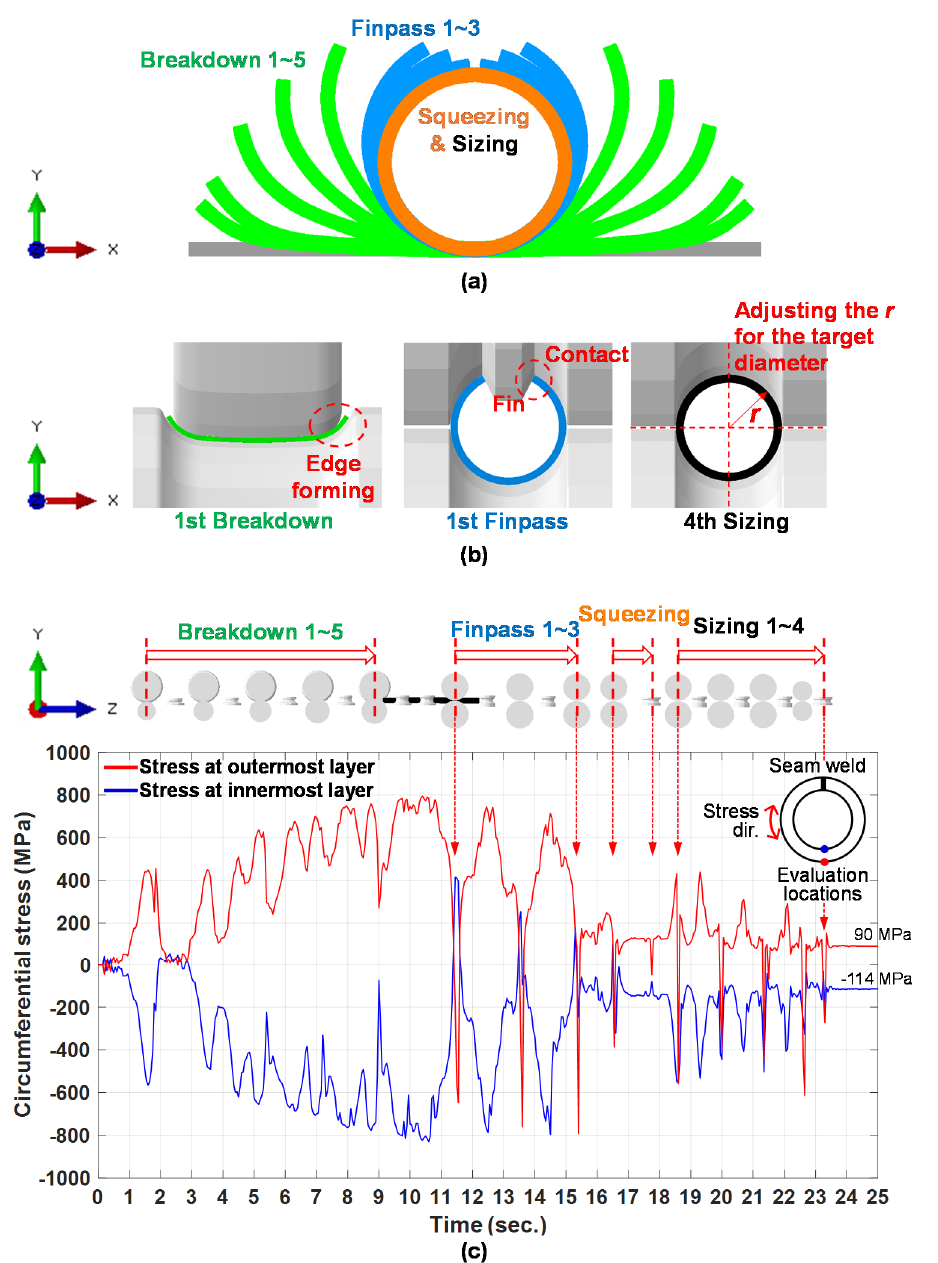
Figure 5. Typical results of the simulation: ( a ) roll-flower; ( b ) shapes of the cross-sections under each roller; ( c ) circumferential roller; ( c ) circumferential stress.